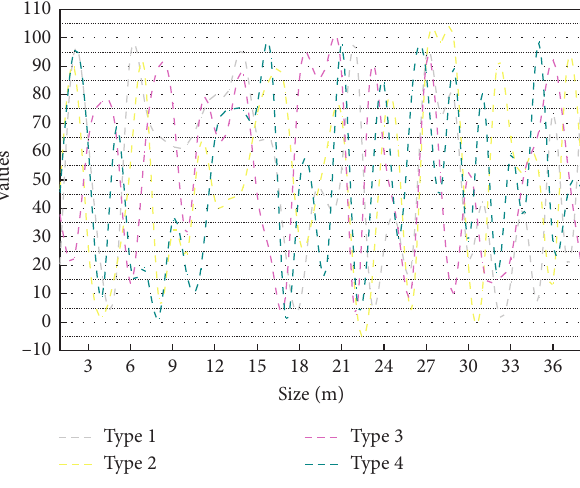
Figure 4: Numeric